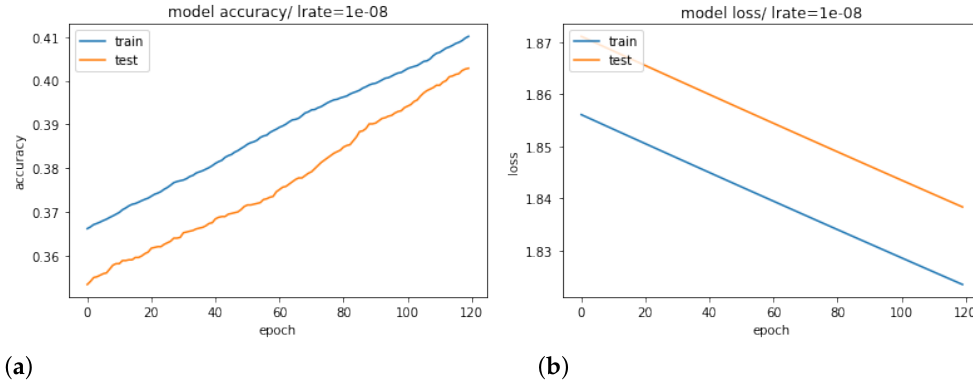
Figure 13. lr = 1 × 10 − 8 . ( a ) Train accuracy: 0.410. ( b ) Test accuracy: